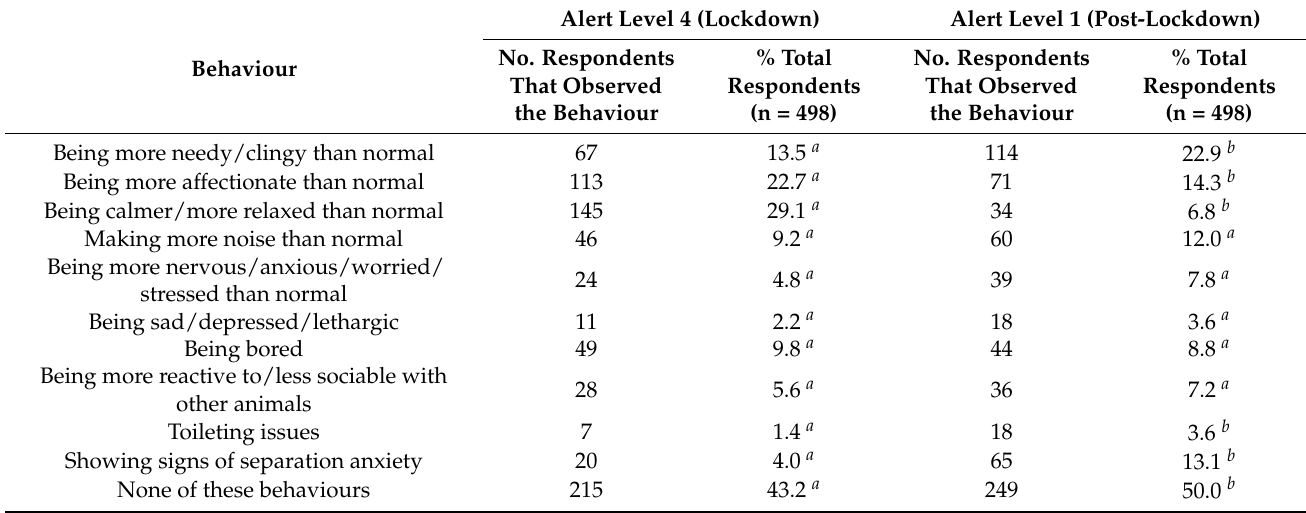
Table 7. Percentage of respondents that observed specified pet behaviours during Alert Level 4 (Lockdown) and Alert Level 1